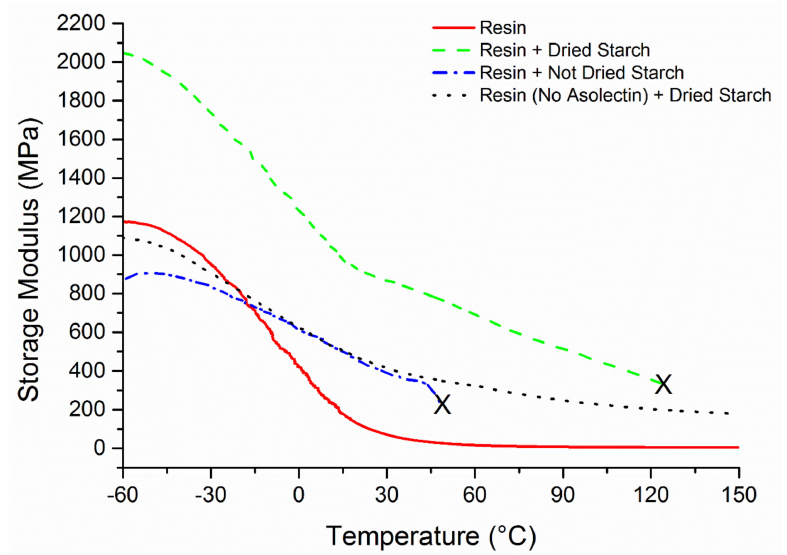
Figure 7. Storage modulus vs. temperature of the unreinforced resin, and starch composites prepared with dry and not dry starch, and with or without asolectin. The resin contained 30 wt.% of BMA, 20 wt.% of DVB, 40 wt.% of tung oil, and 10 wt.% of asolectin, and was cured at 140 ◦ C for 3 h and 20 min. Premature yielding of the samples is indicated with the symbol